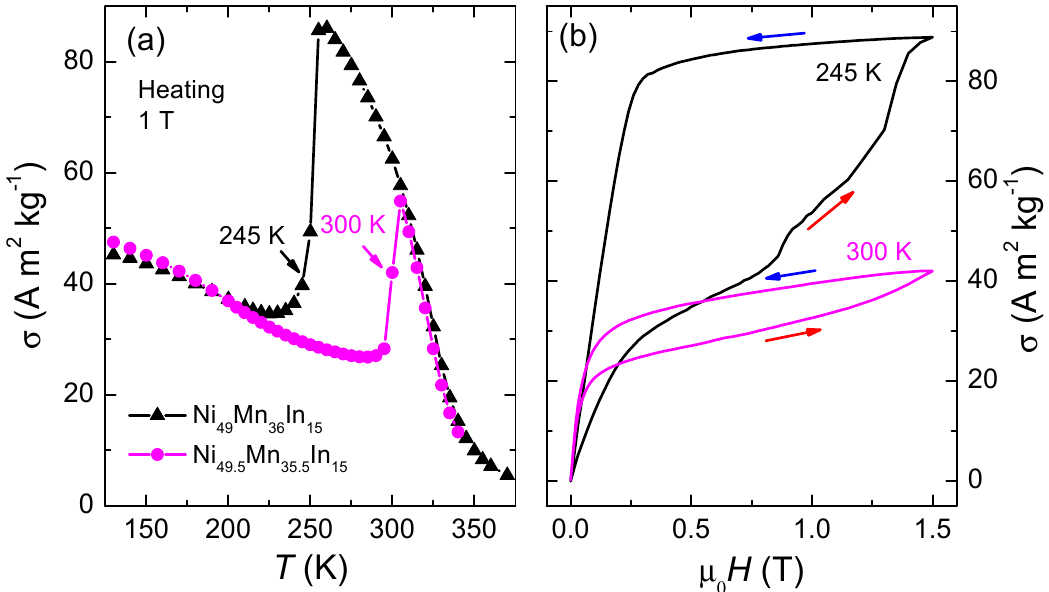
Figure 1. ( a ) Temperature dependence of magnetization of Ni 49 Mn 36 In 15 and Ni 49.5 Mn 35.5 In 15 samples measured at selected fields. ( b ) Magnetization / demagnetization curves at temperatures close to the martensitic transition. Table 1. Heating and cooling discontinuous protocols on erasing the sample (cid:48) s history used in this work. Heating Cooling Set the temperature well below the martensitic Set the temperature well above the martensitic transition at low field transition at high field Set the desired measurement temperature Set the desired measurement temperature Measure ∆ T ad from low to high field Measure ∆ T ad from high to low field Repeat the steps before measurement Repeat the steps before measurement at a di ff erent temperature at a di ff erent